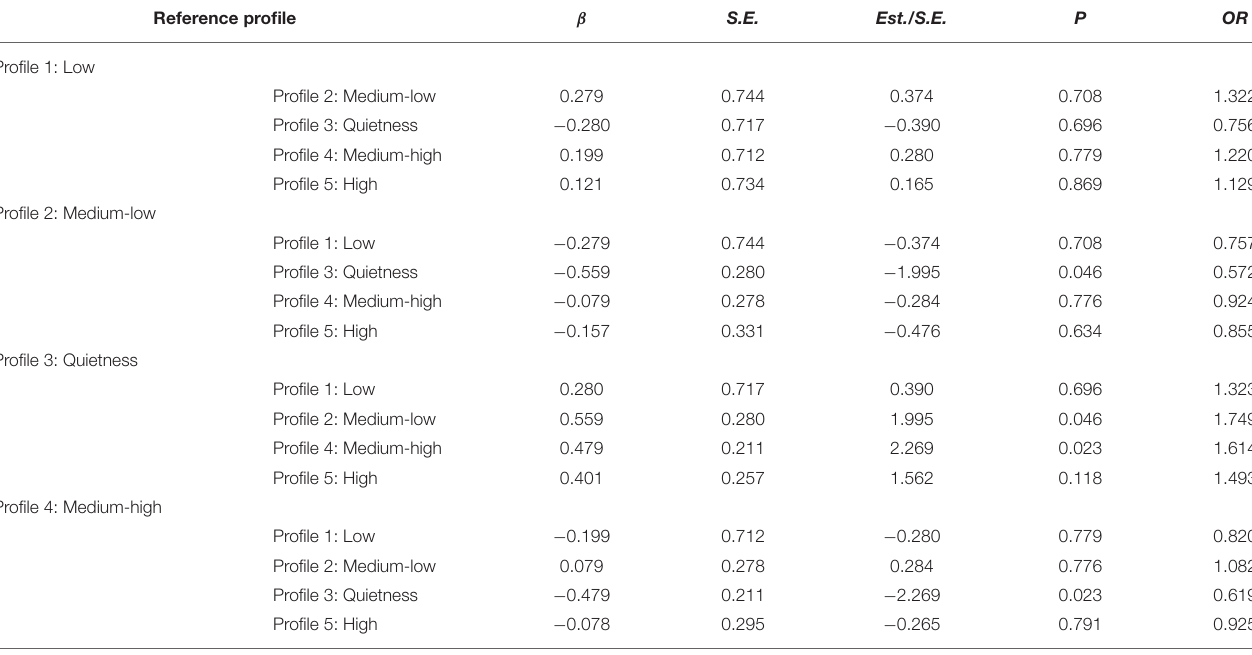
TABLE 4 | Results of multinomial logistic regression analysis on gender.